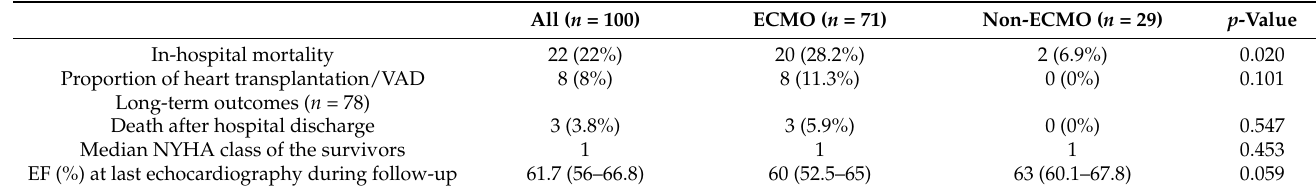
Table 2. Clinical outcomes.